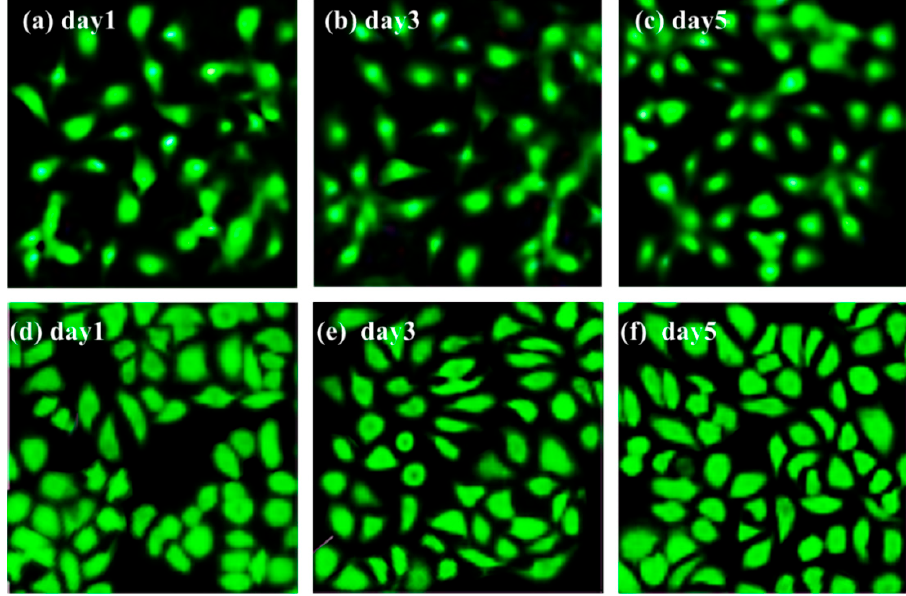
Figure 9. Fluorescence images of proliferated cells on different specimens: ( a – c ): porous UHMWPE; ( d – f ): porous UHMWPE/FANC 12.5 .